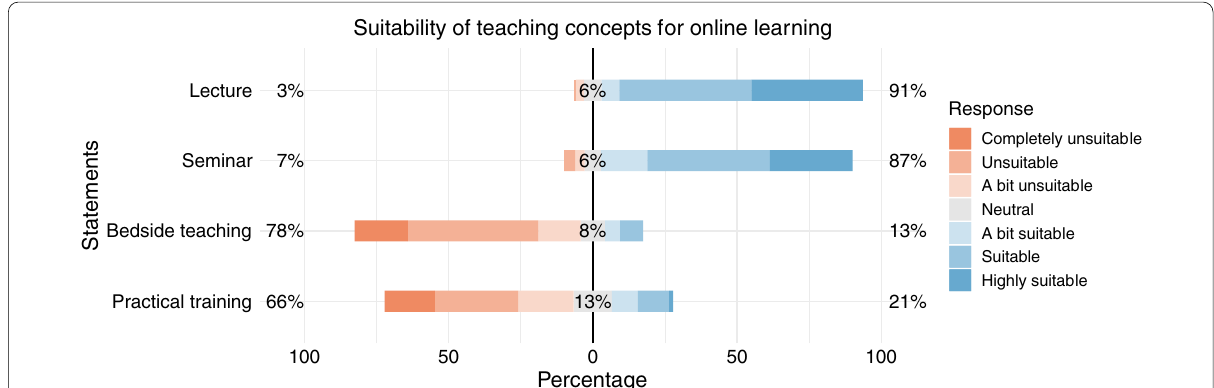
Fig. 2 Ranking of teaching concepts being suitable for online learning. It includes four categories and ranges from highly suitable (lecture) to unsuitable (practical training)